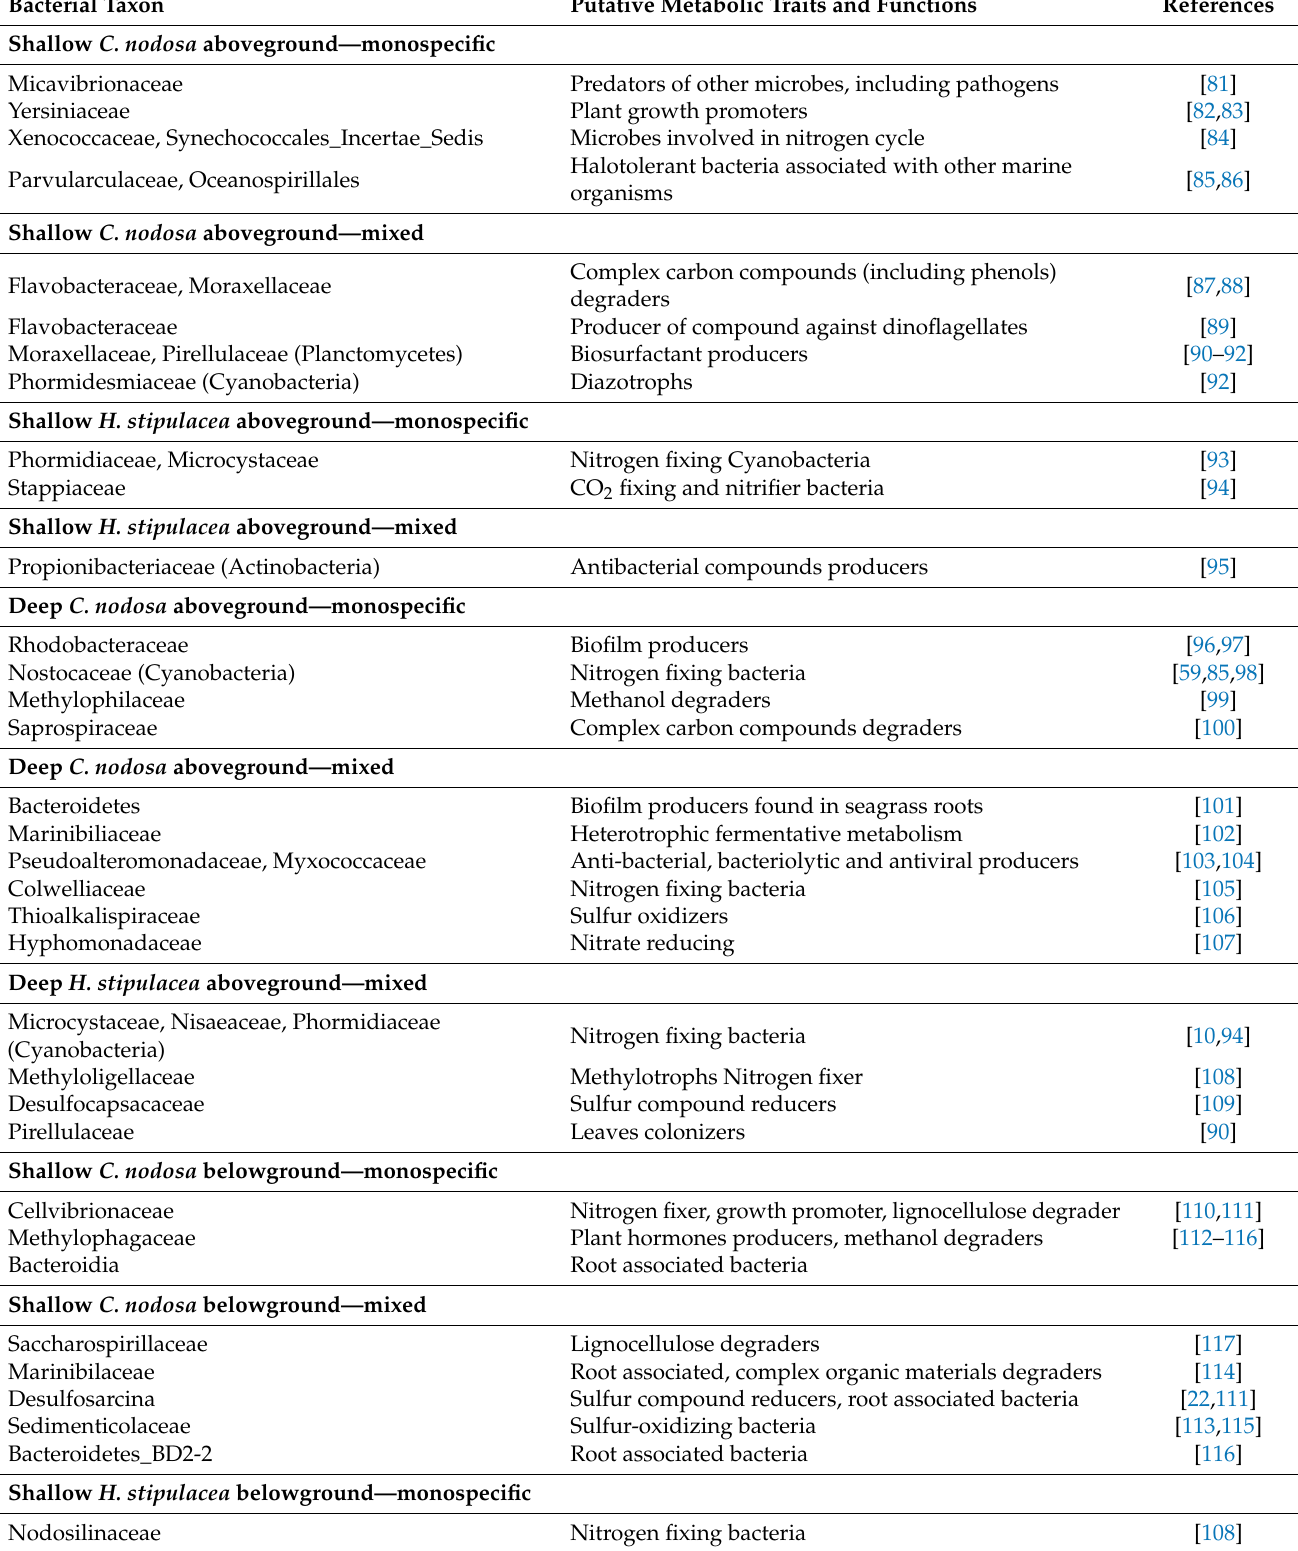
Table 6. Host-specific bacterial partners significantly associated with aboveground or belowground versions of each seagrass in the two sites, and their putative